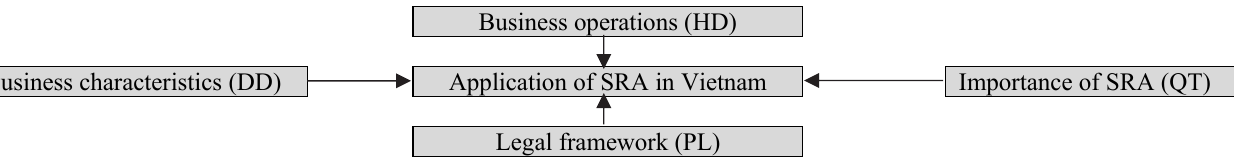
Fig. 1. Research framework for factors affecting Application of social responsibility accounting in Vietnamese enterprise Variables’